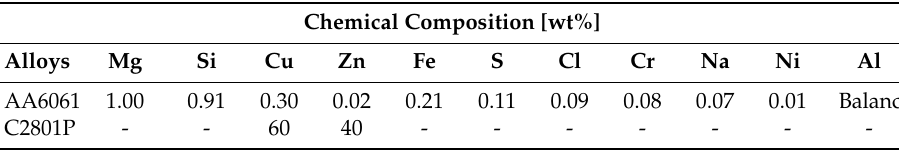
Table 1. Chemical composition of the welded materials.